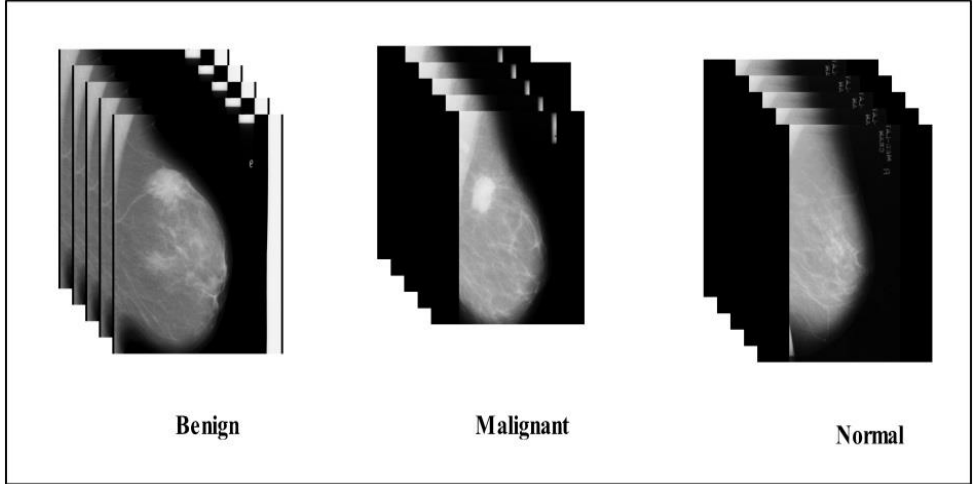
Figure 4. Sample images of MIAS dataset.